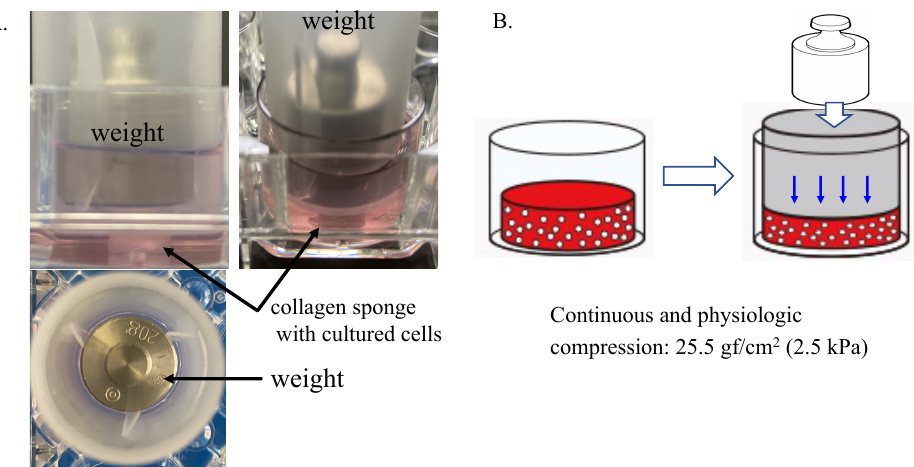
Figure 1. Three-dimensional cell–collagen scaffold construct. Continuous and physiologic com- pression was applied to the tested 3D constructs at 0 kPa (non-loaded) or 25.5 gf/cm 2 (2.5 kPa). ( A ) Representative images of the generation of the 3D cell–collagen scaffold construct for human cultured cells. ( B ) Scheme showing mechanical loading of the 3D cell culture